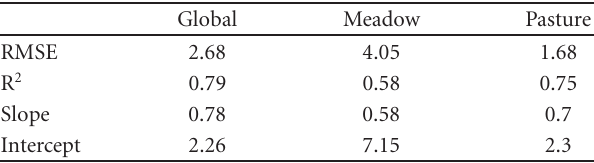
Table 2: Estimation accuracies achieved by the proposed algorithm with the best input feature configuration.